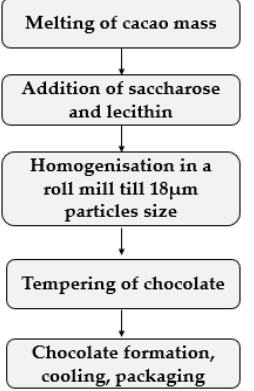
Figure 1. Technological scheme of chocolate